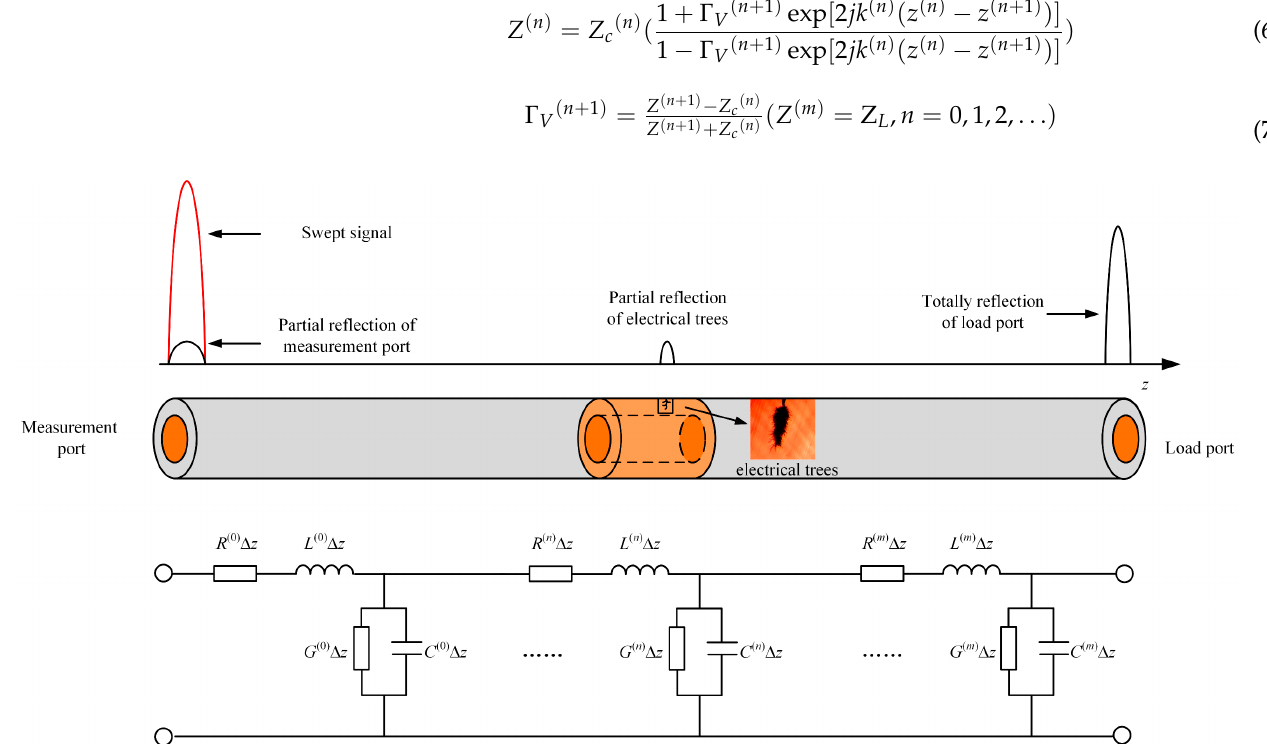
Figure 4. The principle of locating electrical trees by the BIS test.